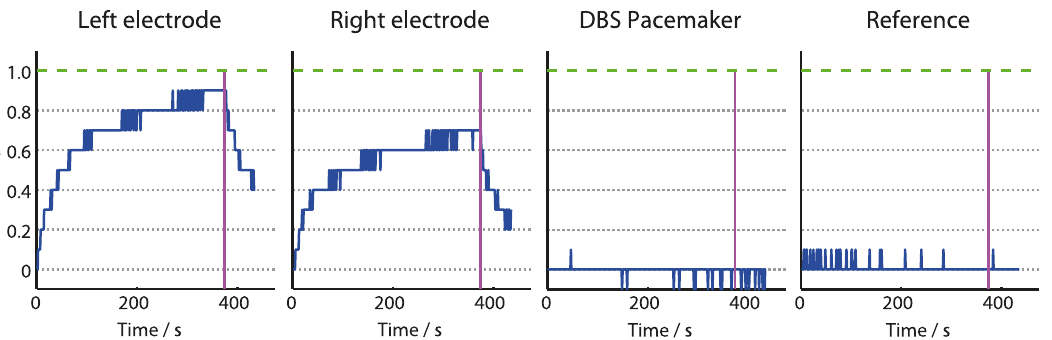
Fig 4. Typical temperature time courses observed during a TSE sequence at the 4 thermometer sites using the body-transmit coil. Green line is our safety threshold (1°C). Pink line indicates the end of the scan. Note the TSE sequence acted as positive control, producing temperature increases greater than the sequences used for subjects with in situ DBS at our